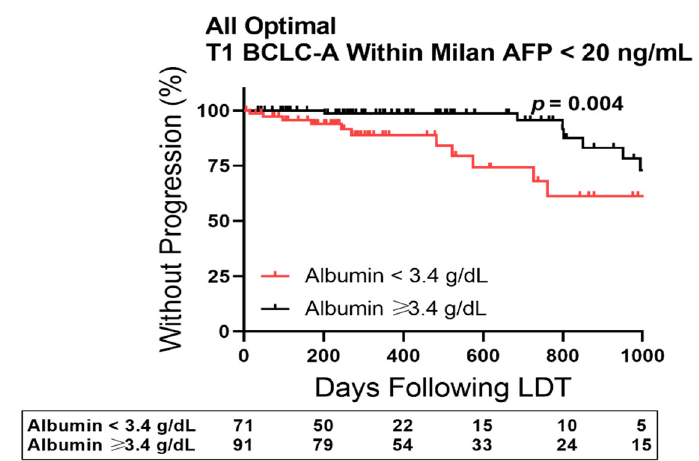
Figure 6. Albumin-Stratified Kaplan–Meier Curves of Time to Progression in Optimal Bridge to Liver transplant (LT) Patients. Plot restricted to patients with burden at diagnosis defined as T1 and within Milan Criteria, with Barcelona Clinic Liver Cancer (BCLC) Stage A disease, and having a baseline alpha-fetoprotein (AFP) < 20 ng/mL. Censored data is marked with a vertical upward dash. The total number of patients remaining in the analysis at each major x-axis time point is listed in the table below the plot. Significance was determined using the Log-Rank test.